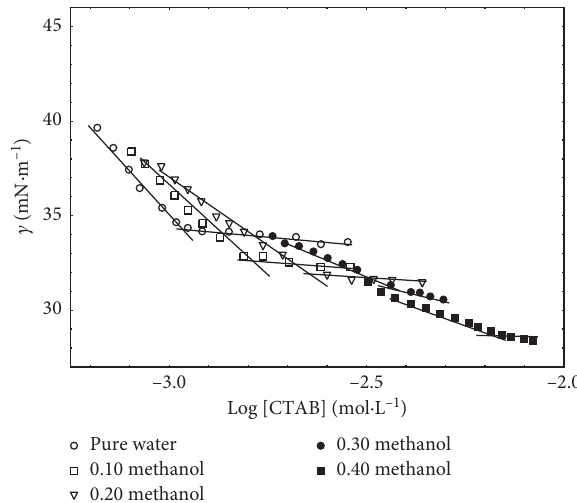
Figure 1: Plot of surface tension versus concentration of CTAB solution at